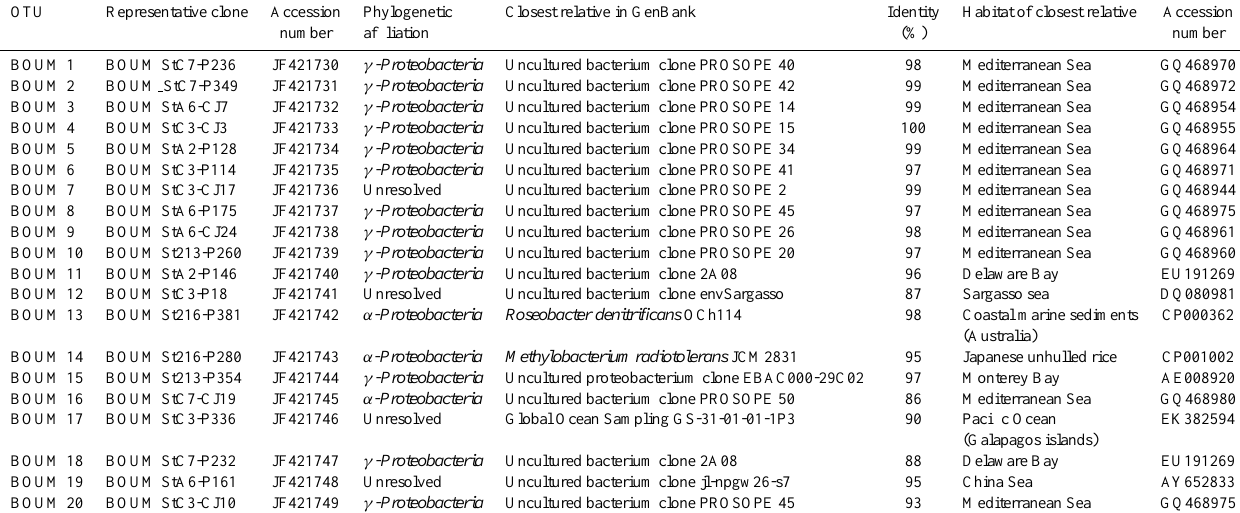
Table 3. Phylogenetic affiliation and accession numbers of operational taxonomic units (OTU) recovered in the RNA-based pufM libraries and general features of their closest relatives in